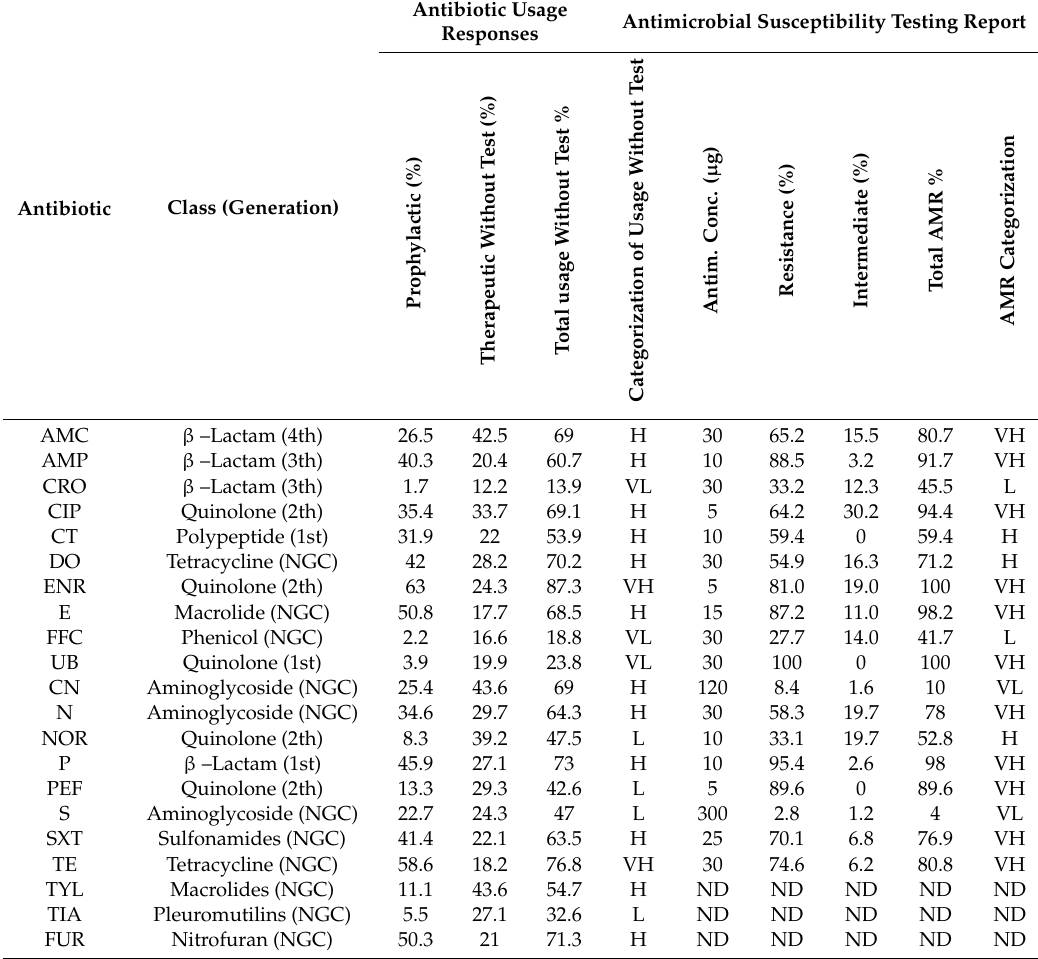
Table 2. Antibiotic usage and antimicrobial susceptibility testing of Salmonella isolates along the broiler production chain of